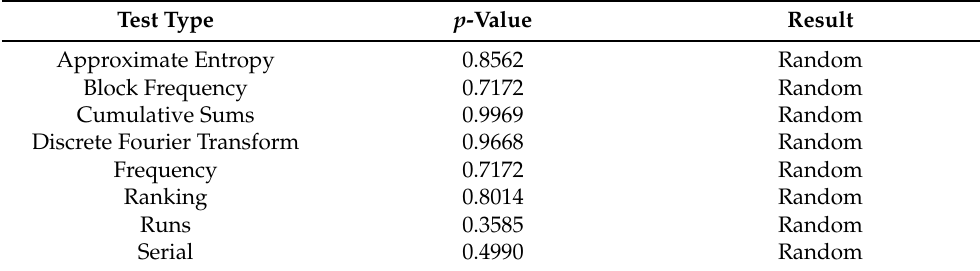
Table 6. NIST statistical test results.